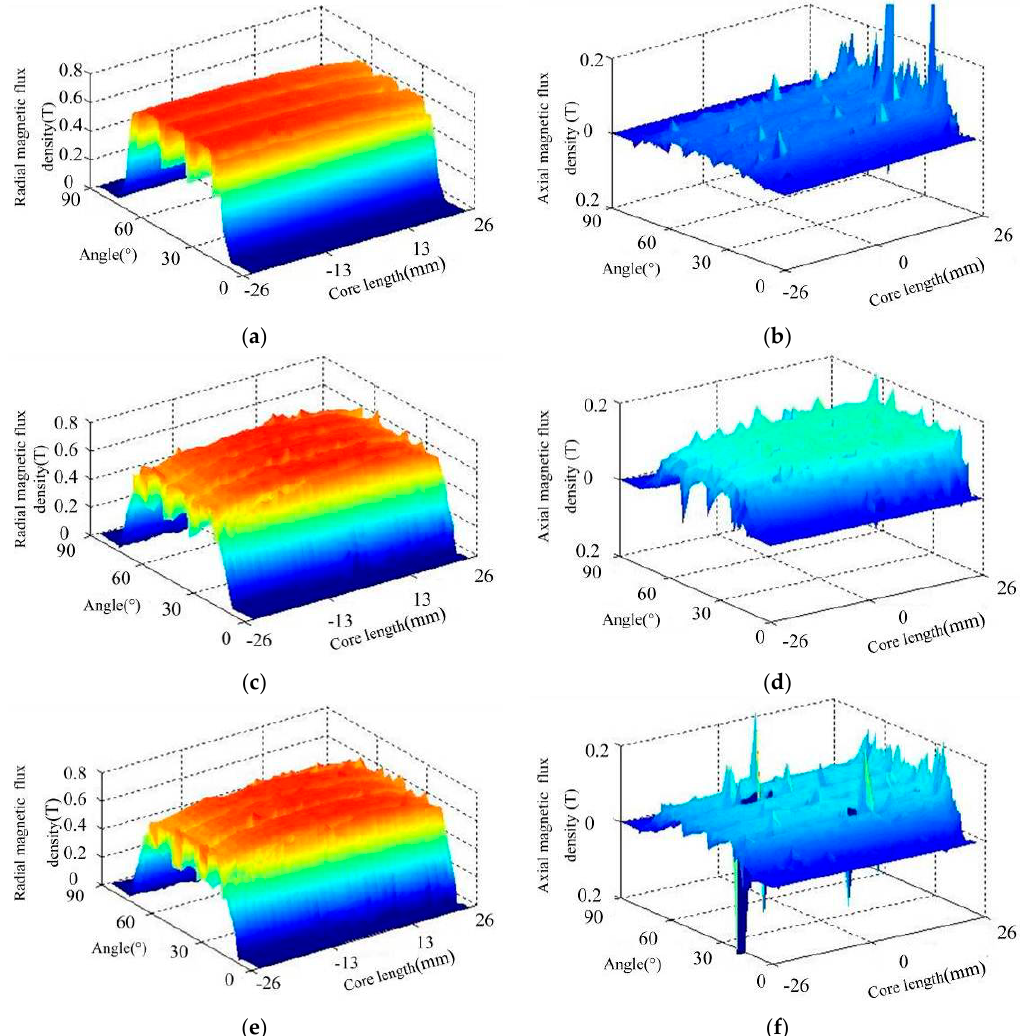
Figure 7. The 3-D magnetic-field distribution of the radial and the axial component at different cone angle: ( a ) B δ r at α = 4°, ( b ) B δ z at α = 4°, ( c ) B δ r at α = 6°, ( d ) B δ z at α = 6°, ( e ) B δ r at α = 8°, ( f ) B δ z at α = 8°.